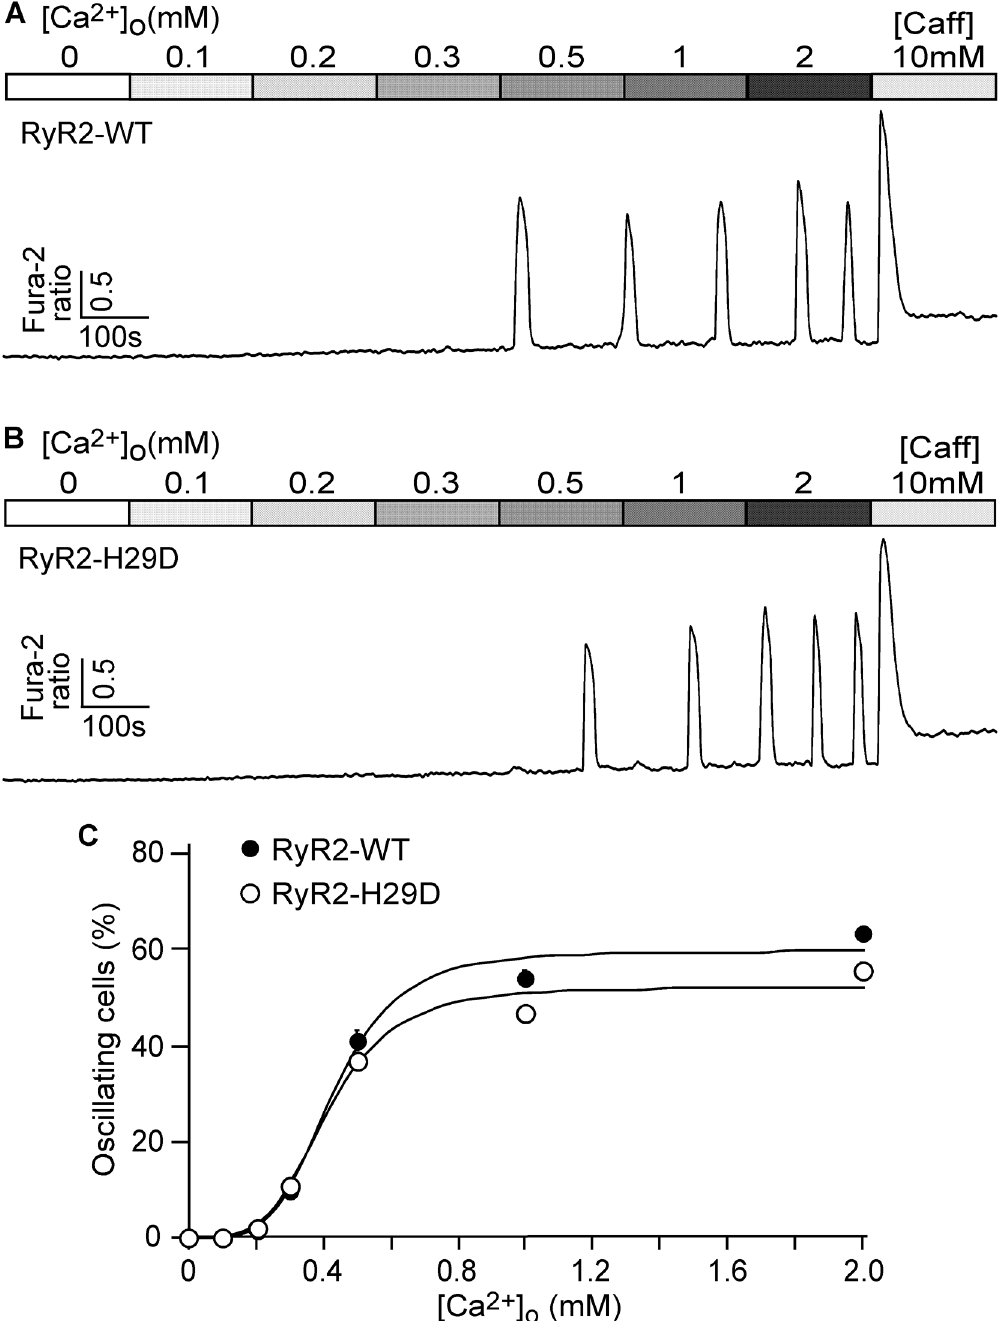
Fig 5. Effect of the H29D mutation on the propensity for SOICR in HEK293 cells. Stable, inducible HEK293 cells expressing RyR2 WT and the H29D mutant were loaded with 5 μ M Fura-2 AM in KRH buffer. The cells were then perfused continuously with KRH buffer containing increasing levels of extracellular Ca 2+ (0 – 2 mM) to induce SOICR. Fura-2 ratios of representative RyR2 WT (A) and H29D (B) cells were recorded using epifluorescence single cell Ca 2+ imaging. (C) The percentages of RyR2 WT (total 1087 cells) and H29D (total 1161 cells) cells that display Ca 2+ oscillations at various extracellular Ca 2+ concentrations. Data shown are mean ± SEM (n = 9 –